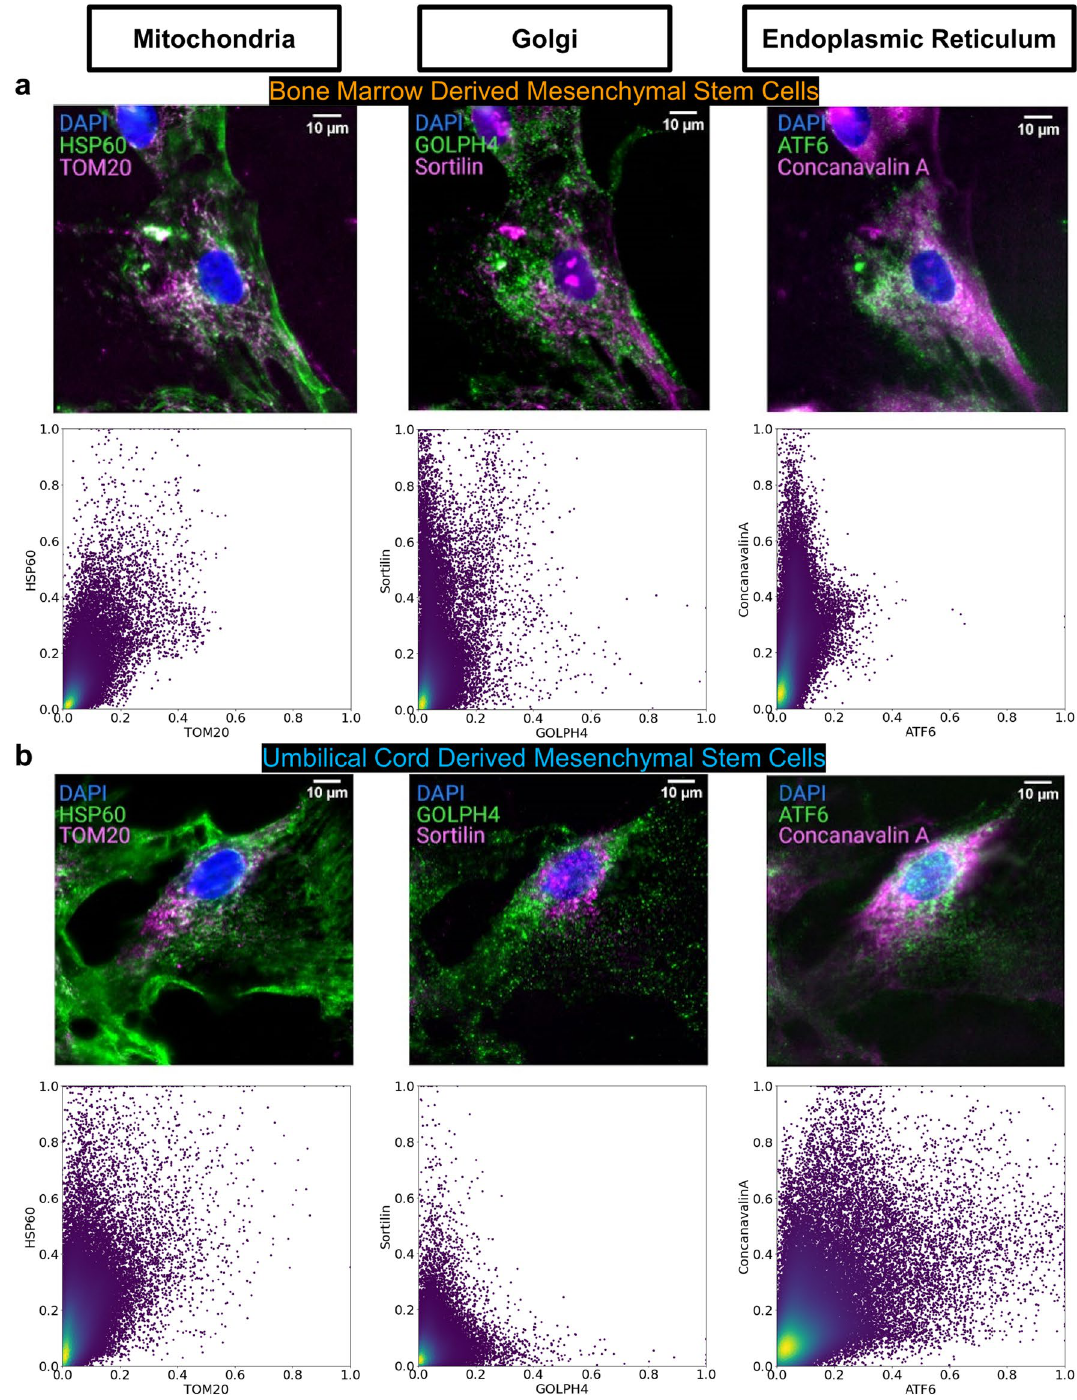
Figure 2. Comparison of protein markers targeting the same organelles in BM MSCs and UC MSCs. ( a ) Single BM MSC example with various organelles across the columns. Each organelle is shown by a marker pair: HSP60 & TOM20 (mitochondria, left), GOLPH4 & Sortilin (Golgi, middle), ATF6 & Concanavalin A (ER, right). All scale bars 10 µm. The bottom row shows intensity scatter plots with 50,000 pixels for each marker pair colocalized within the same organelle. The x and y-axis indicate the min–max scaled intensity values of the markers. More colocalized pixels appear closer to the y = x diagonal while less colocalized pixels appear closer to either axis, belonging more to that particular marker. In BM MSCs, mitochondria antibodies are more colocalized than either Golgi or ER. ( b ) Single UC MSC example with various organelles across the columns. Each organelle is shown by a marker pair: HSP60 & TOM20 (mitochondria, left), GOLPH4 & Sortilin (Golgi, middle), ATF6 & Concanavalin A (ER, right). All scale bars 10 µm. The bottom row shows intensity scatter plots with 50,000 pixels for each marker pair colocalized within the same organelle. The x and y-axis indicate the min–max scaled intensity values of the markers. More colocalized pixels appear closer to the y = x diagonal while less colocalized pixels appear closer to either axis, belonging more to that particular marker. In UC MSCs, ER antibodies are more colocalized than either mitochondria or